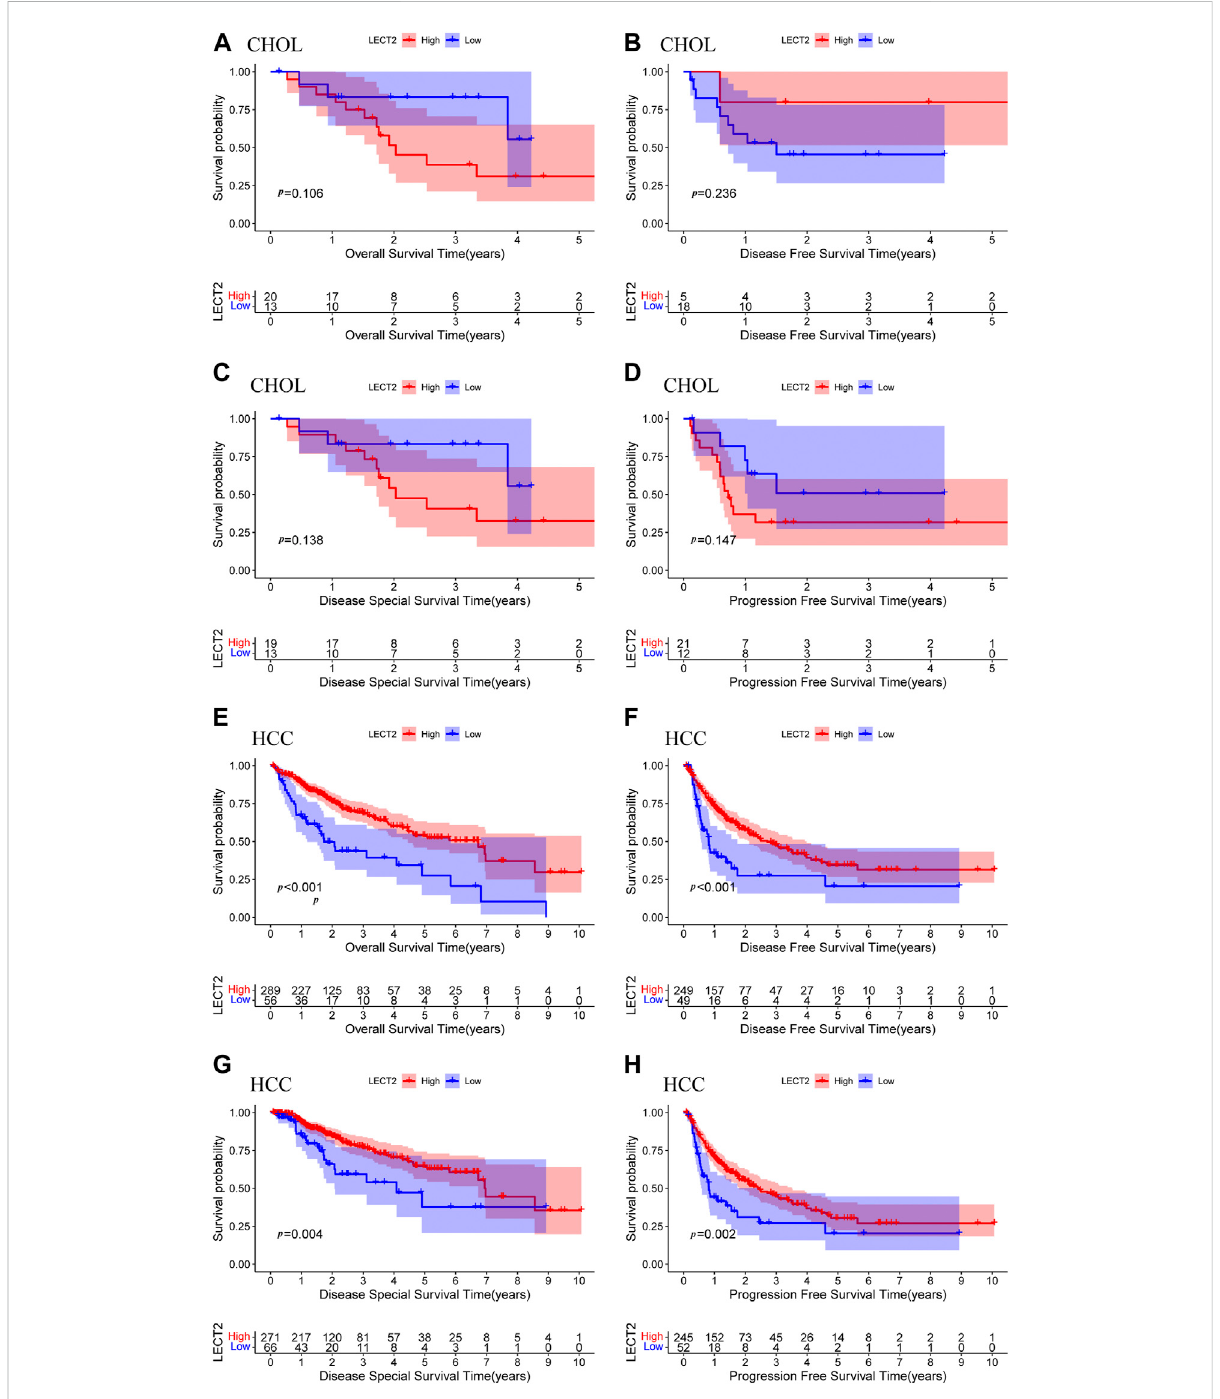
FIGURE 2 PrognosticanalysisofLECT2.OS (A) ,DFS (B) ,DSS (C) ,andPFS (D) ofCHOL patientsweregrouped byhighandlowexpressionofLECT2.OS (E) , DFS (F) ,DSS (G) ,andPFS (H) ofHCCpatientsweregroupedbyhighandlowexpressionofLECT2.OS:overallsurvival,DFS:disease-freesurvival,DSS: disease-speci fi c survival, PFS: progression-free